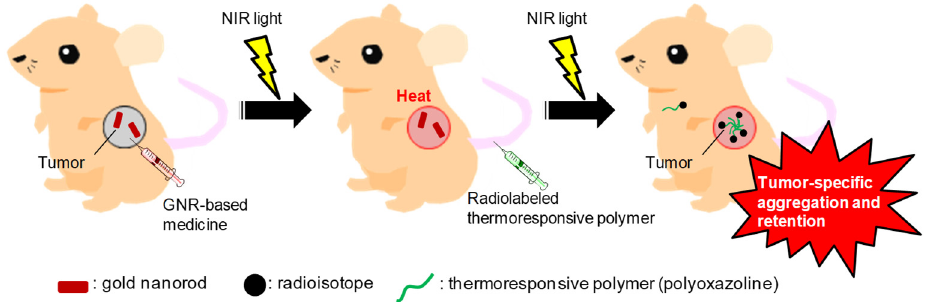
Figure 1. Tested novel drug delivery system using a radiolabeled thermoresponsive polyoxazoline that is self-aggregating in tumor tissue when given gold nanorods (GNRs) and irradiated with near-infrared (NIR) light.